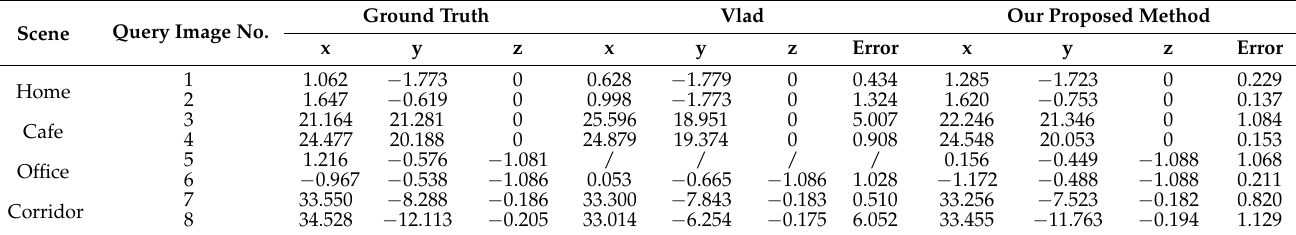
For the fifth image in the query set, the distance between the retrieve result by VLAD and the query image is far, and the two images have no common feature points, so it is impossible to use PnP to solve the pose.